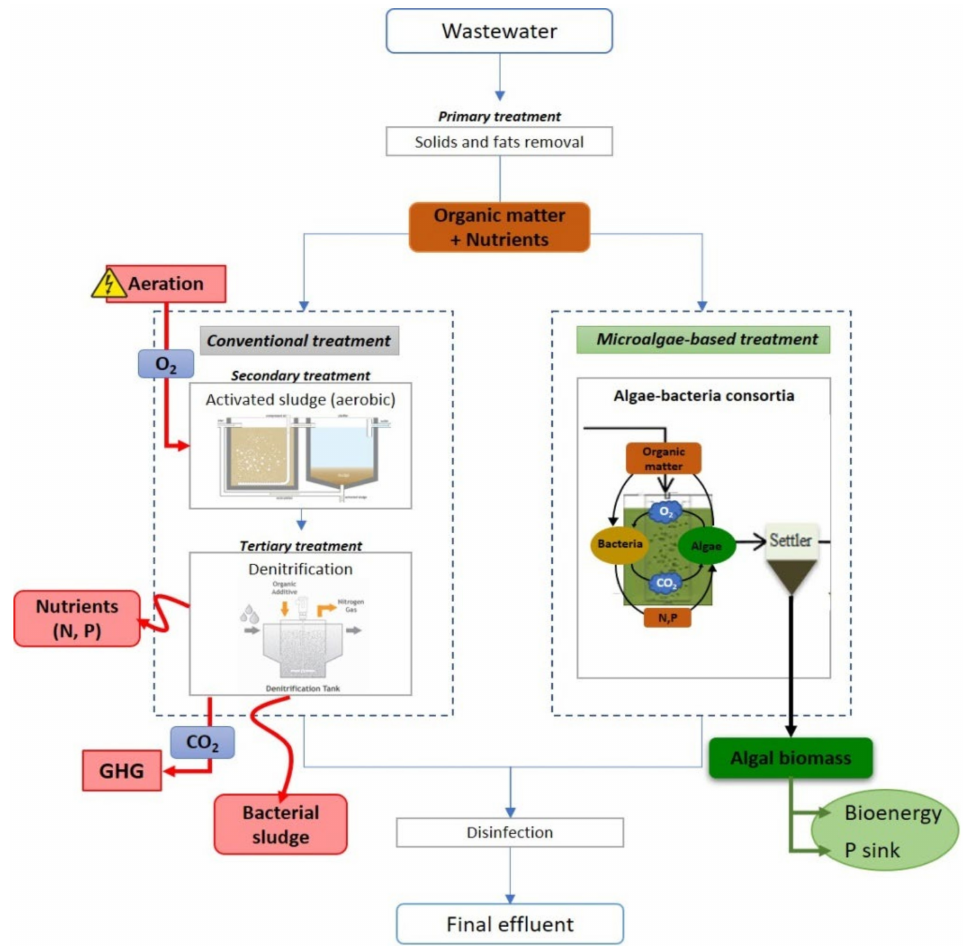
Figure 1. Conventional wastewater treatment versus wastewater treatment-based microalgae